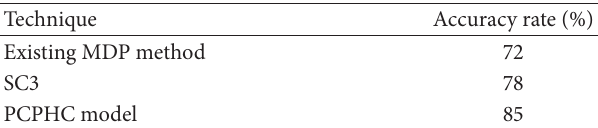
Table 4: Technique versus accuracy rate (using GenBank